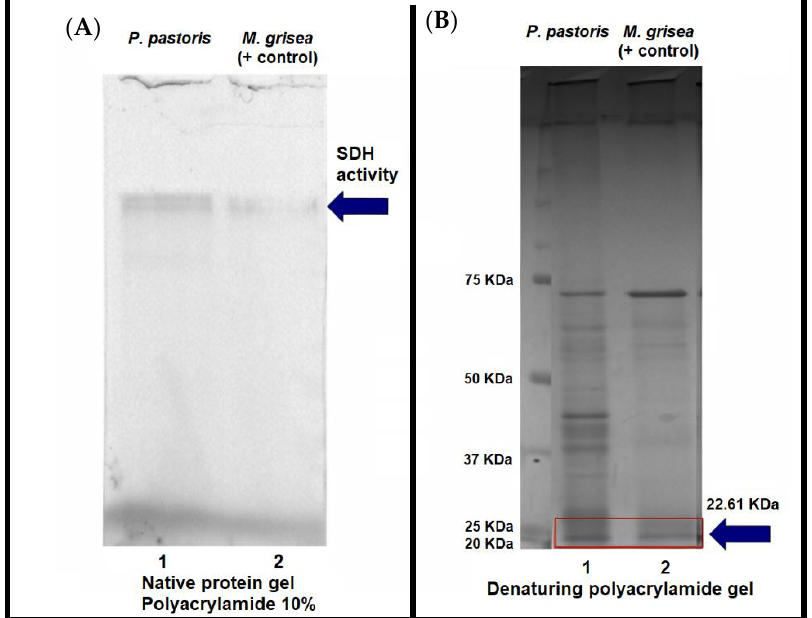
Figure 6. Scytalone dehydratase activity. Zymogram and SDS-PAGE of the recombinant scytalone dehydratase expressed in P. pastoris . ( A ) Zymogram, line 1: crude culture supernatant from P. pastoris transformed with pPICZ α B/ sdh ; line 2: positive activity control, M. grisea protein extracts, SDH detected activity is indicated. ( B ) SDS-PAGE: Proteins recovered from zymogram analysis; line 1, recombinant SDH protein (22.61 kDa); line 2, positive control from M. grisea